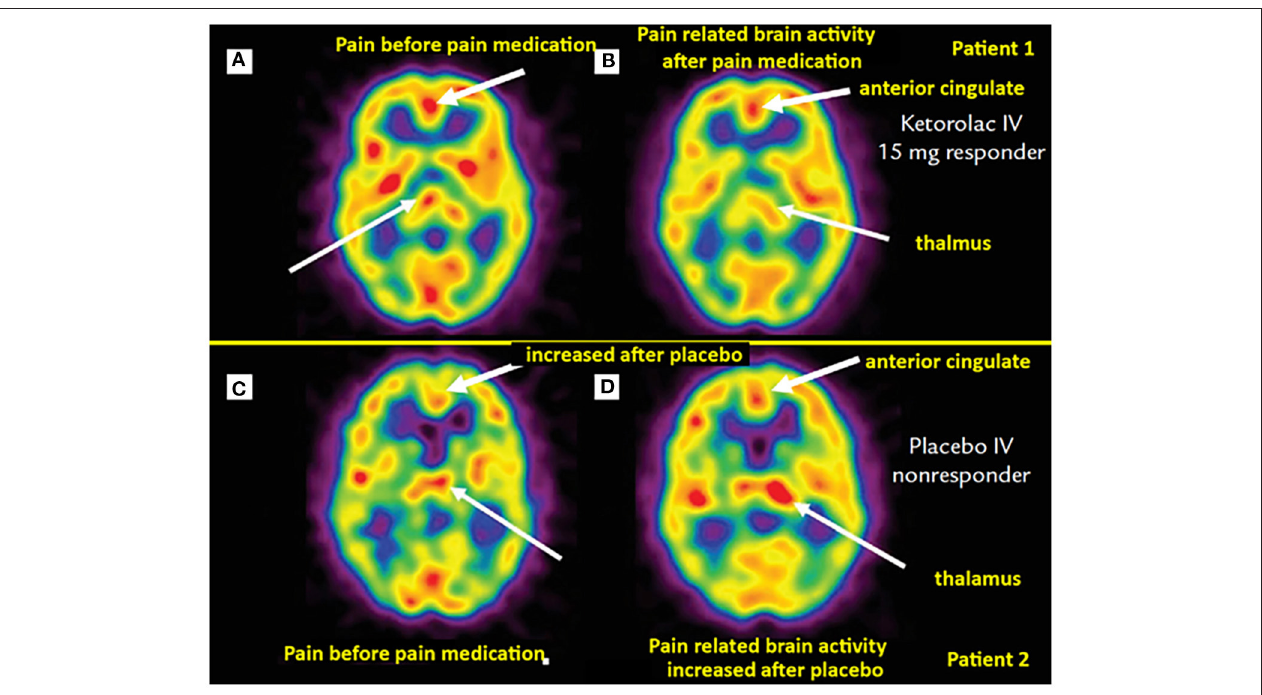
FIGURE 1 | Brain perfusion SPECT of dental pain patients receiving analgesia (top row) vs. placebo (bottom row). (A) Asymmetric thalamic activity, more on the right (thin arrow). Post IV ketorolac, the post-interventional scan (B) of the same patient exhibits a slight “switch” in thalamic asymmetry, with mildly greater perfusion on the left (thin arrow). Noted also decreased perfusion in the anterior cingulate region with pain relief [thick arrows in (A) and (B) ]. (C) Scan from another patient demonstrating mild asymmetric increased activity in the left thalamus (thin arrow). (D) Same patient with worsening pain after receiving IV placebo, the scan demonstrates more asymmetrically increased perfusion in the left thalamus (thin arrow). Not also increased perfusion in the anterior cingulate cortex compared to (C) (thick arrows). [Images by Newberg et al. ( 58), reproduced here with